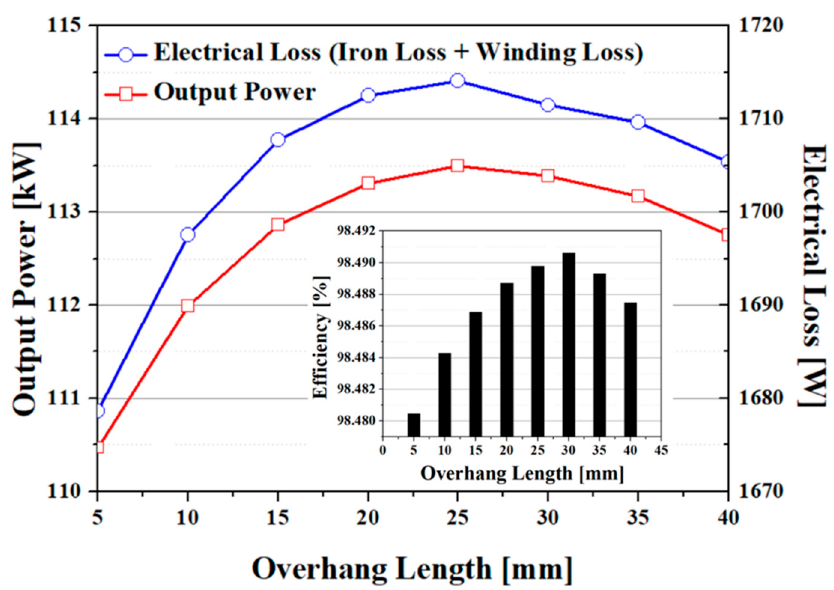
Figure 7. Output power and electrical loss according to overhang length. Inset: efficiency vs. overhang length.